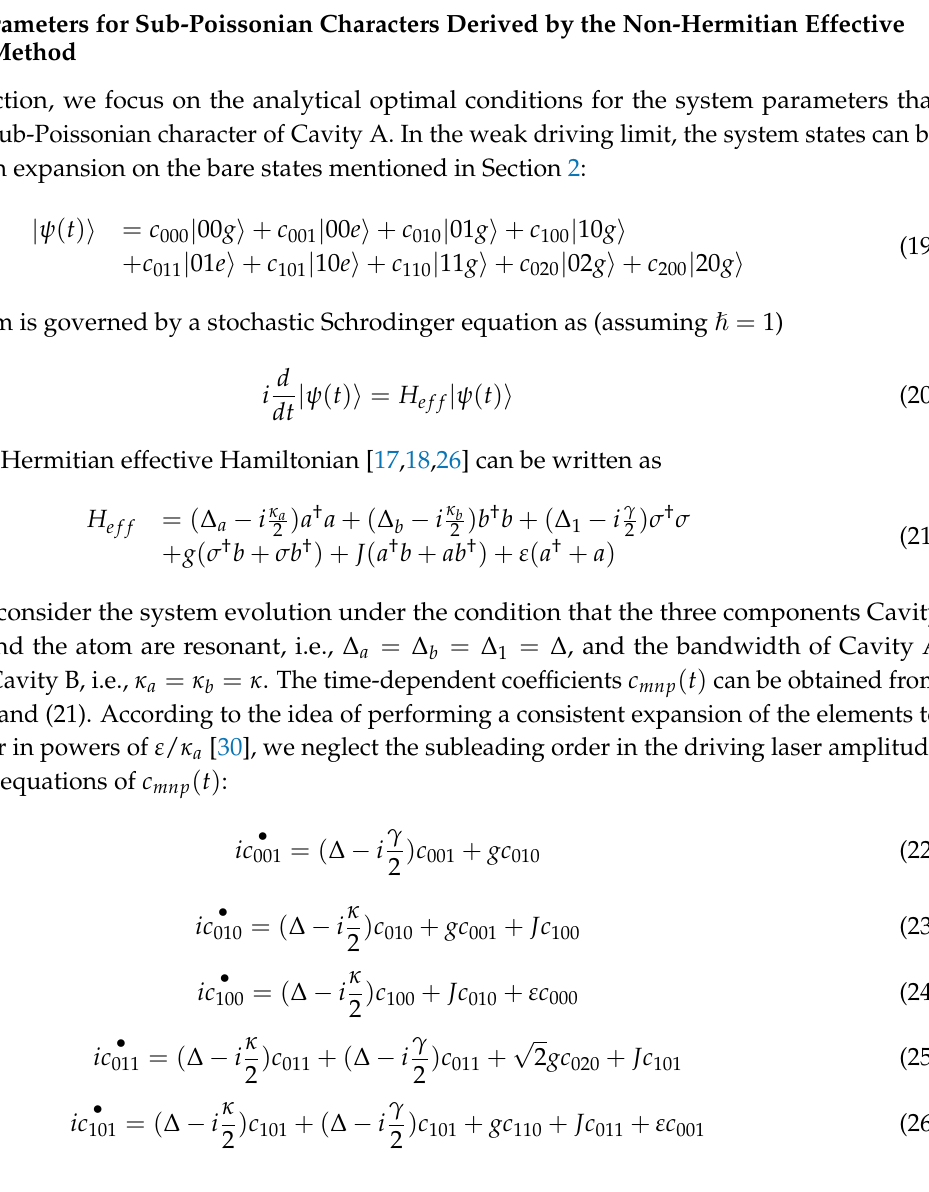
Figure 7. The equal-time second-order correlation function log ∆ ∆ a / κ a and b / κ b under the condition of the atom resonant with the driving laser and ( b ) J = 6 κ a . Other parameters are the same as in Figure